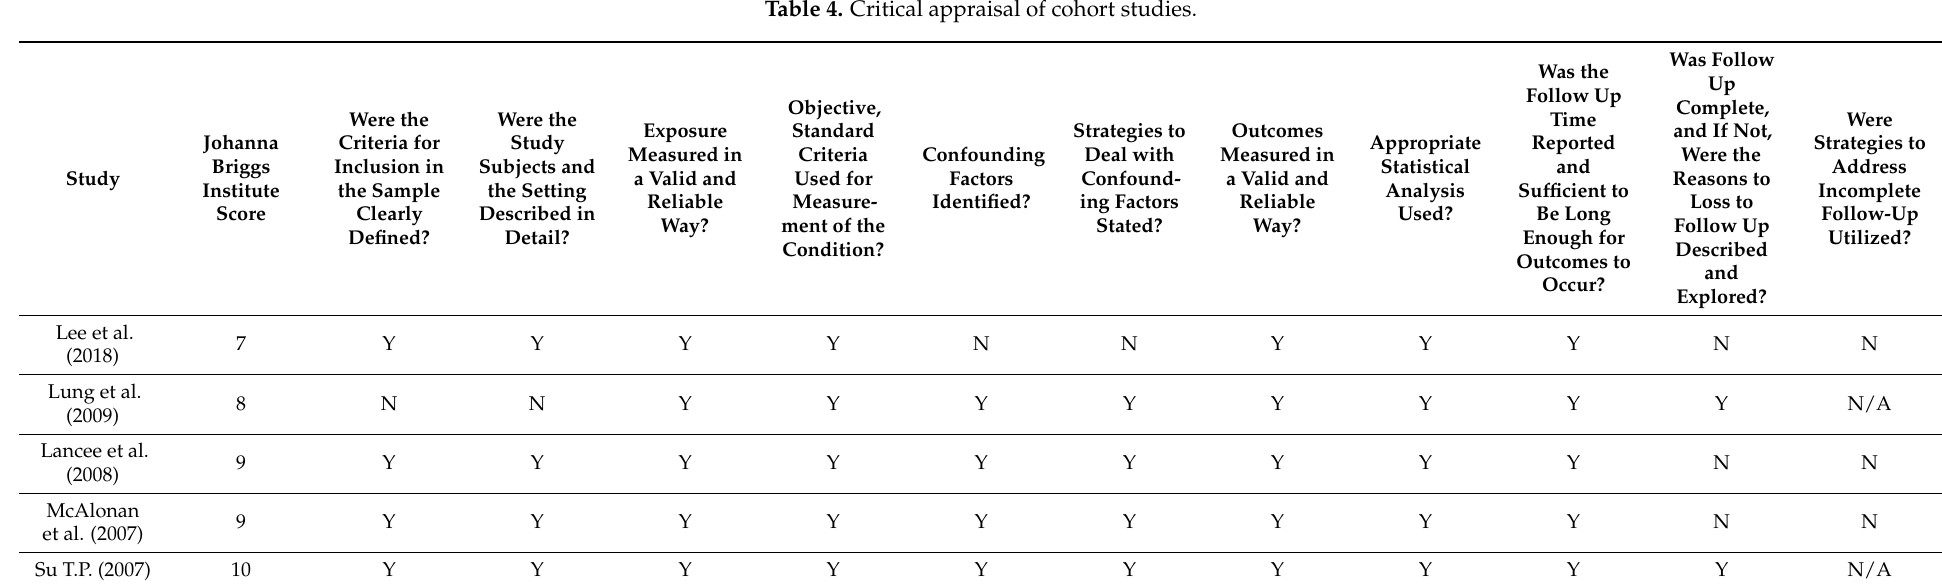
Table 4. Critical appraisal of cohort